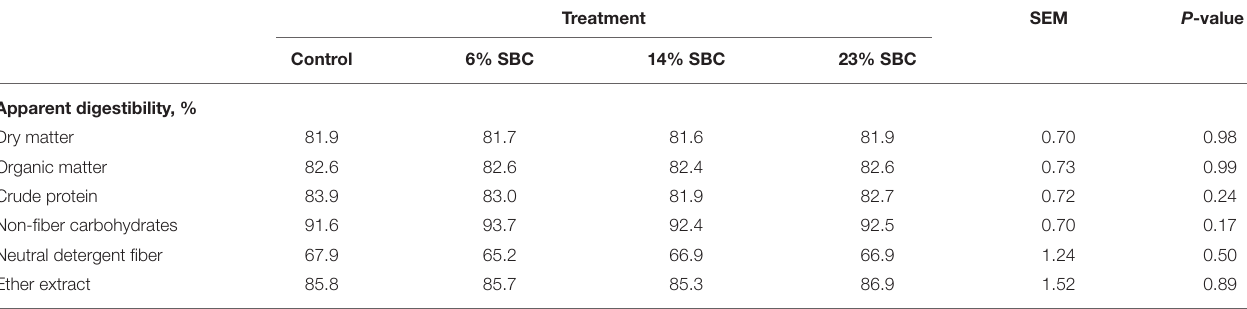
TABLE 5 | Effect of replacing soybean meal (SBM) with soybean cake (SBC) on apparently nutrient digestibility in dairy